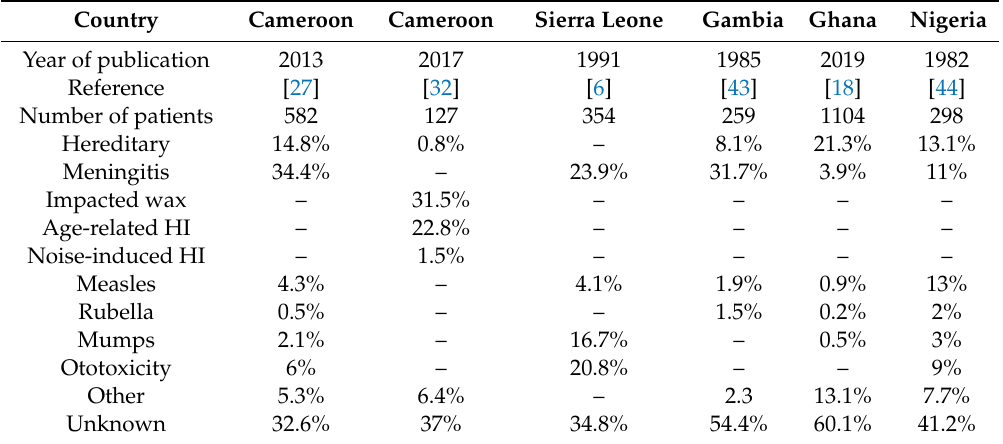
Table 2. Etiologies of hearing impairment in Cameroon and comparison to other African countries.